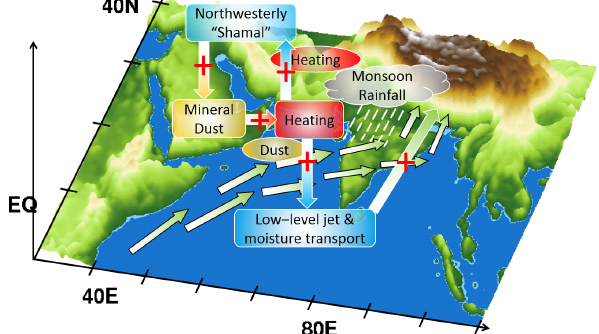
Figure 18. Schematic diagram shows the physical mechanism for the Middle East dust–ISM rainfall connection. Red plus signs rep- resent positive responses. The positive feedback between dust emis- sions, atmospheric heating, and shamal winds is seen as a cycle over the Middle East and the Arabian